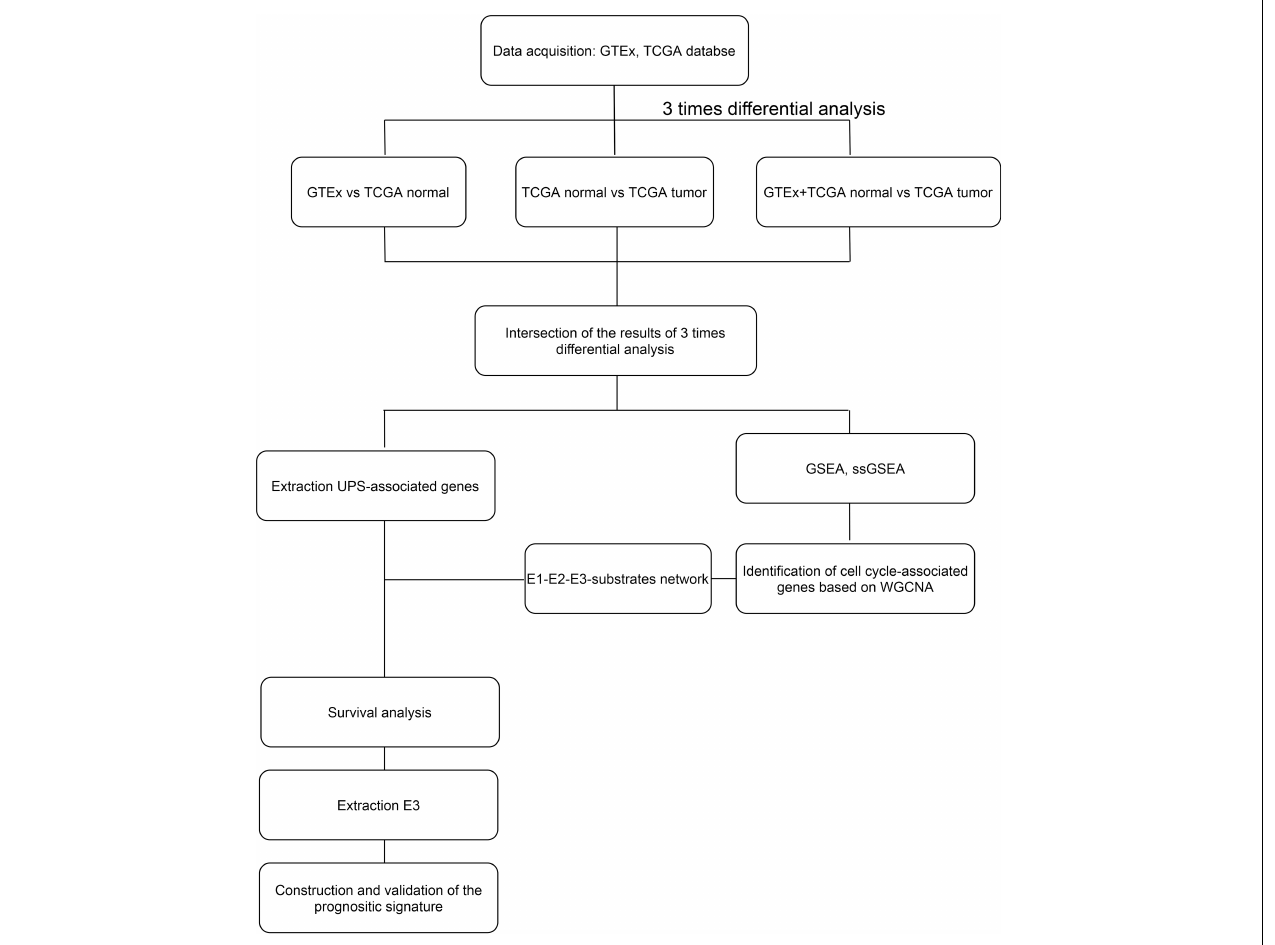
FIGURE 1 | Flow chart of the entire